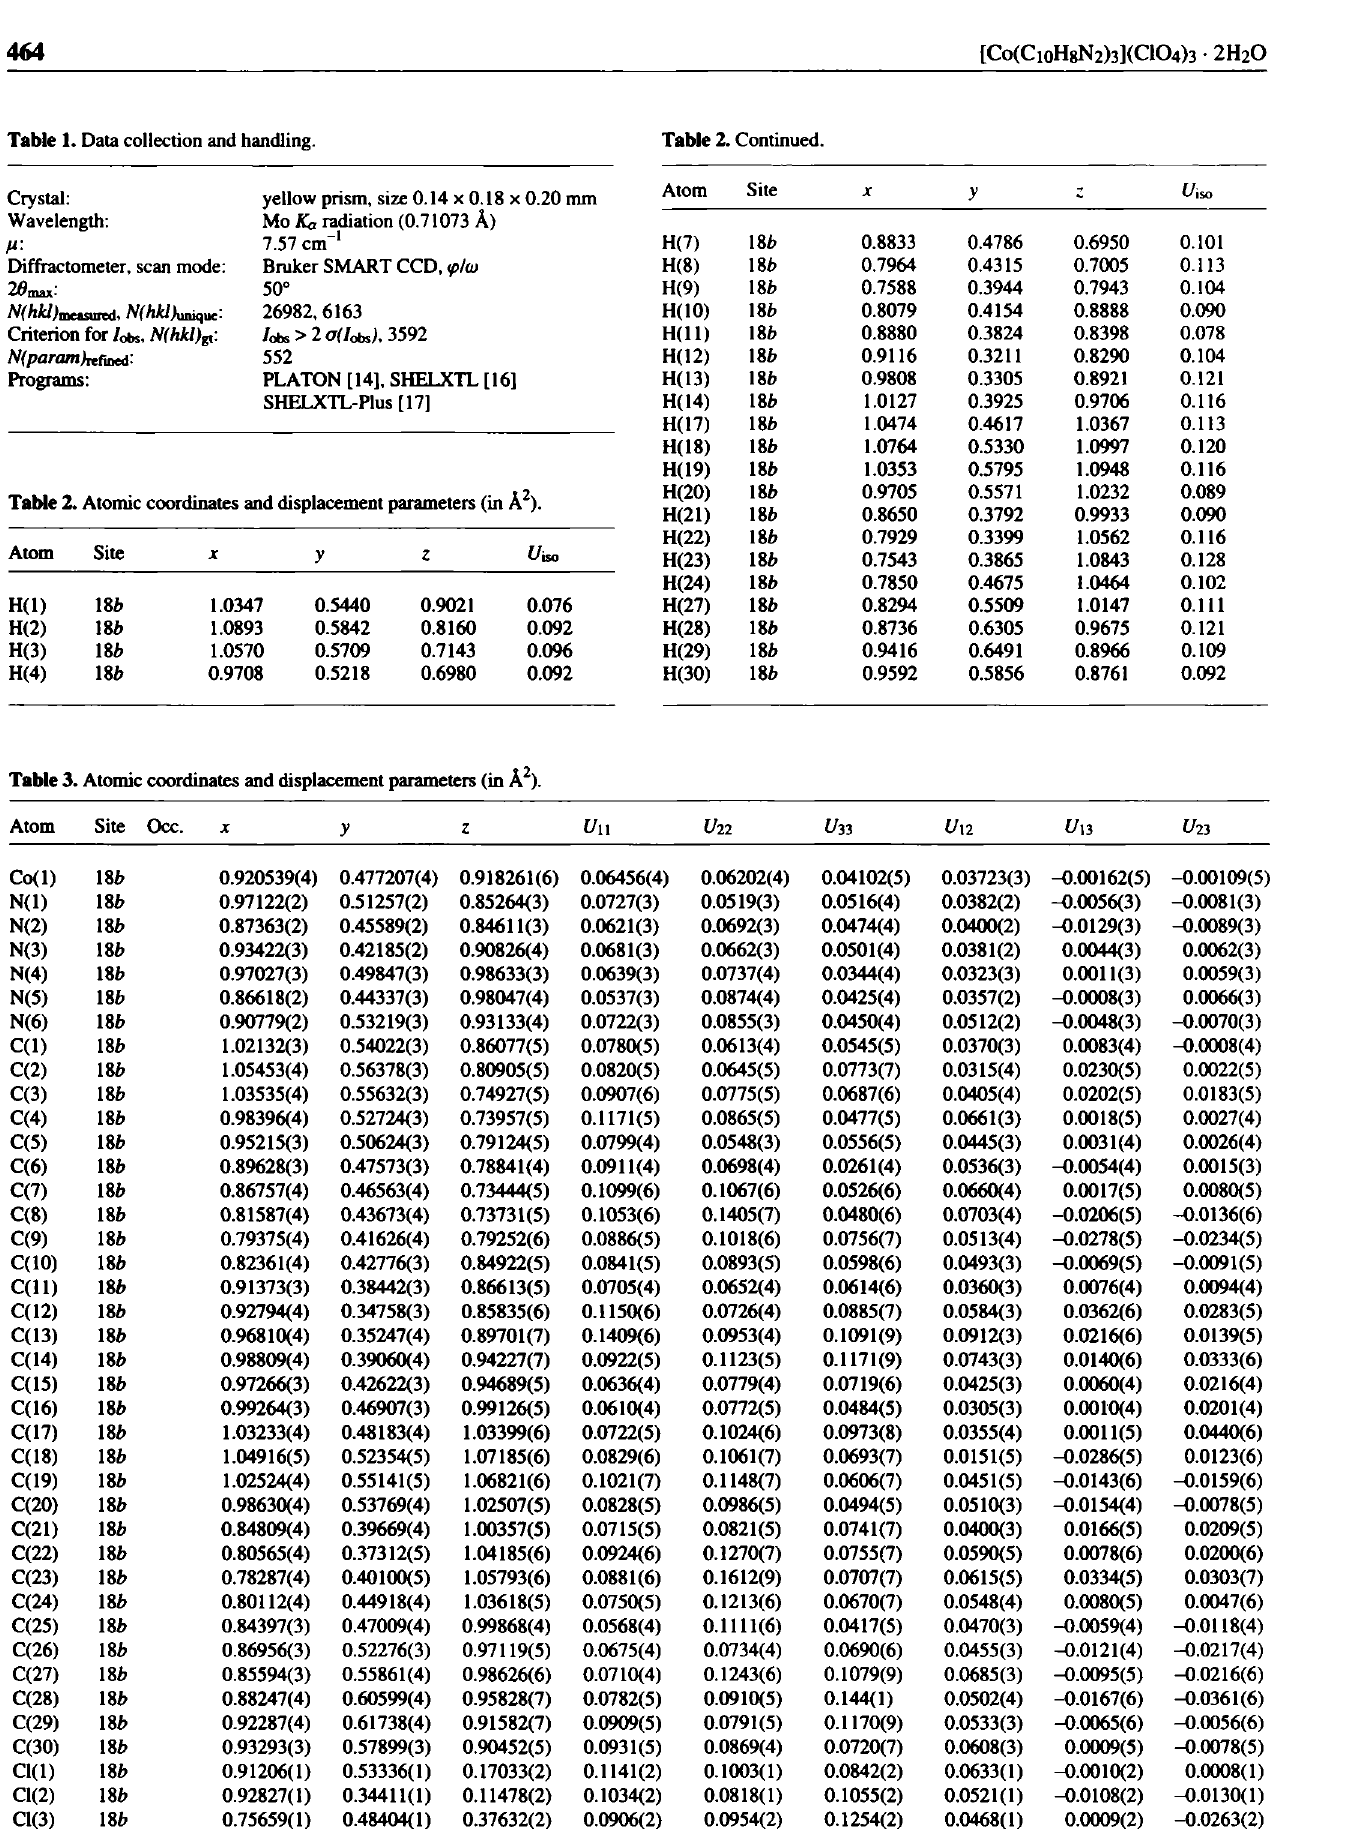
Table 1. Data collection and handling.